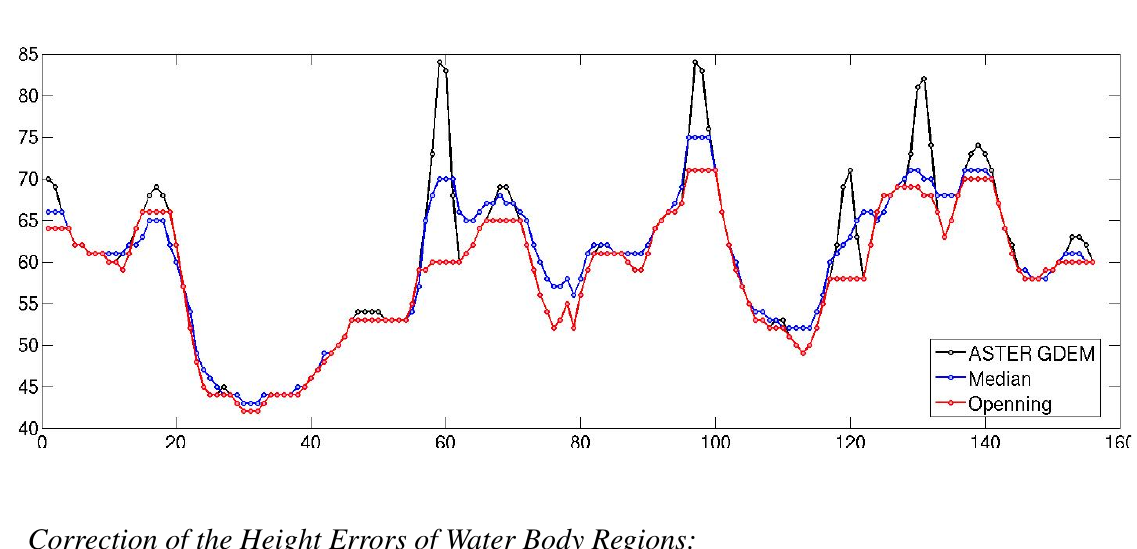
Figure 12. Profiles from images represented in Figure 11, showing that the median filter does not suppress properly the mole-runs